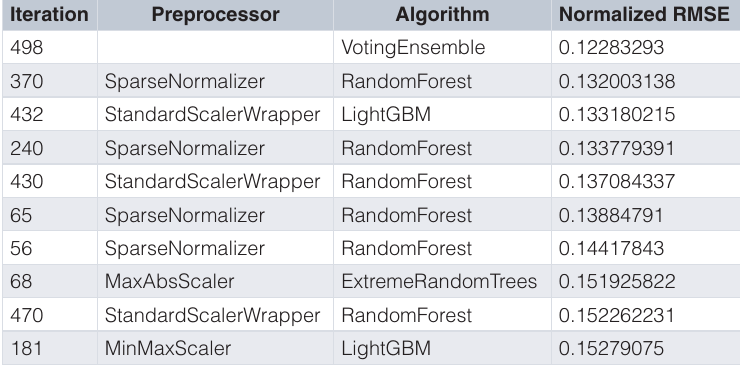
model search, evaluated by Root 50